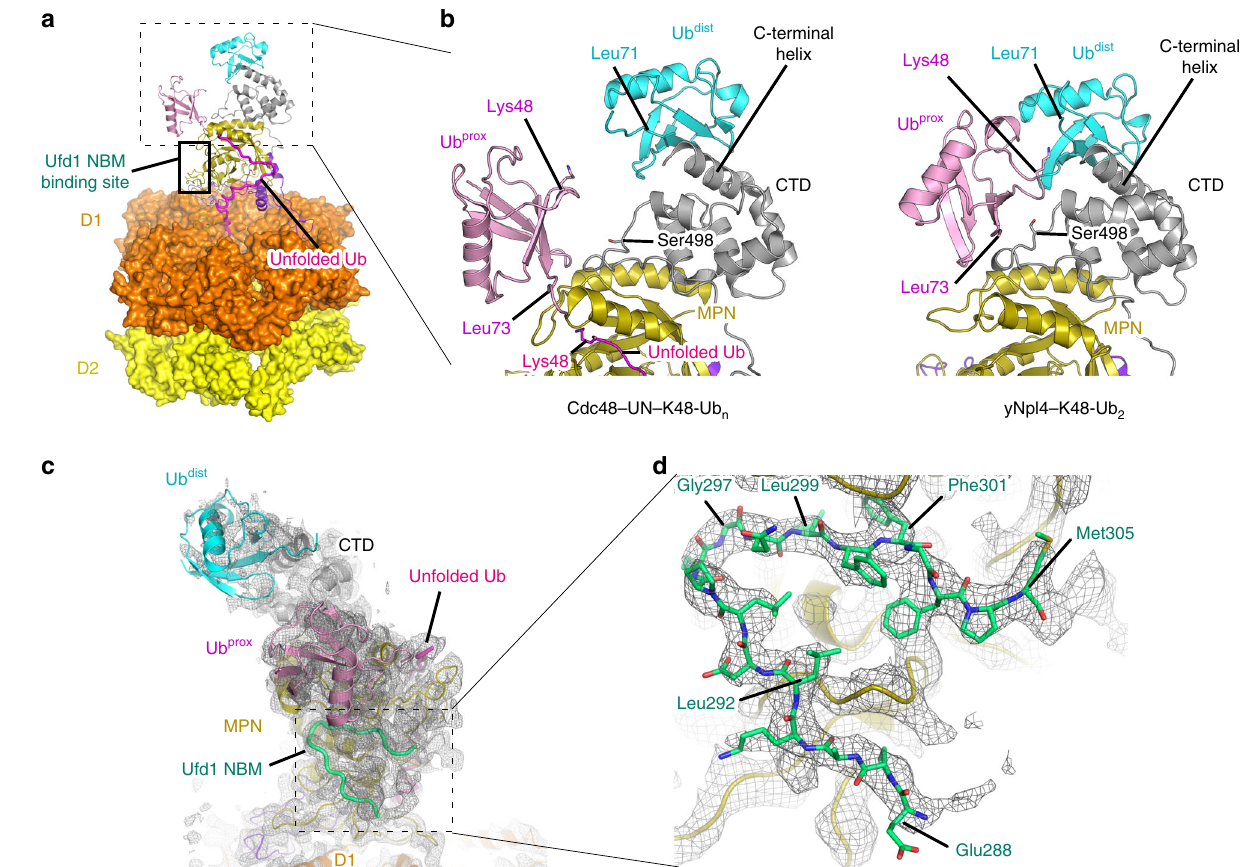
Fig. 6 Comparison of the structures of yNpl4 – K48-Ub 2 , yNpl4 – yUdf1 and the substrate-engaged Cdc48 – UN complex. a Overall view of the cryo-EM structure of the Cdc48 – UN complex (PDB 6OA9 [https://doi.org/10.2210/pdb6oa9/pdb]) 22 . The coloring scheme is the same as that in Fig. 1.